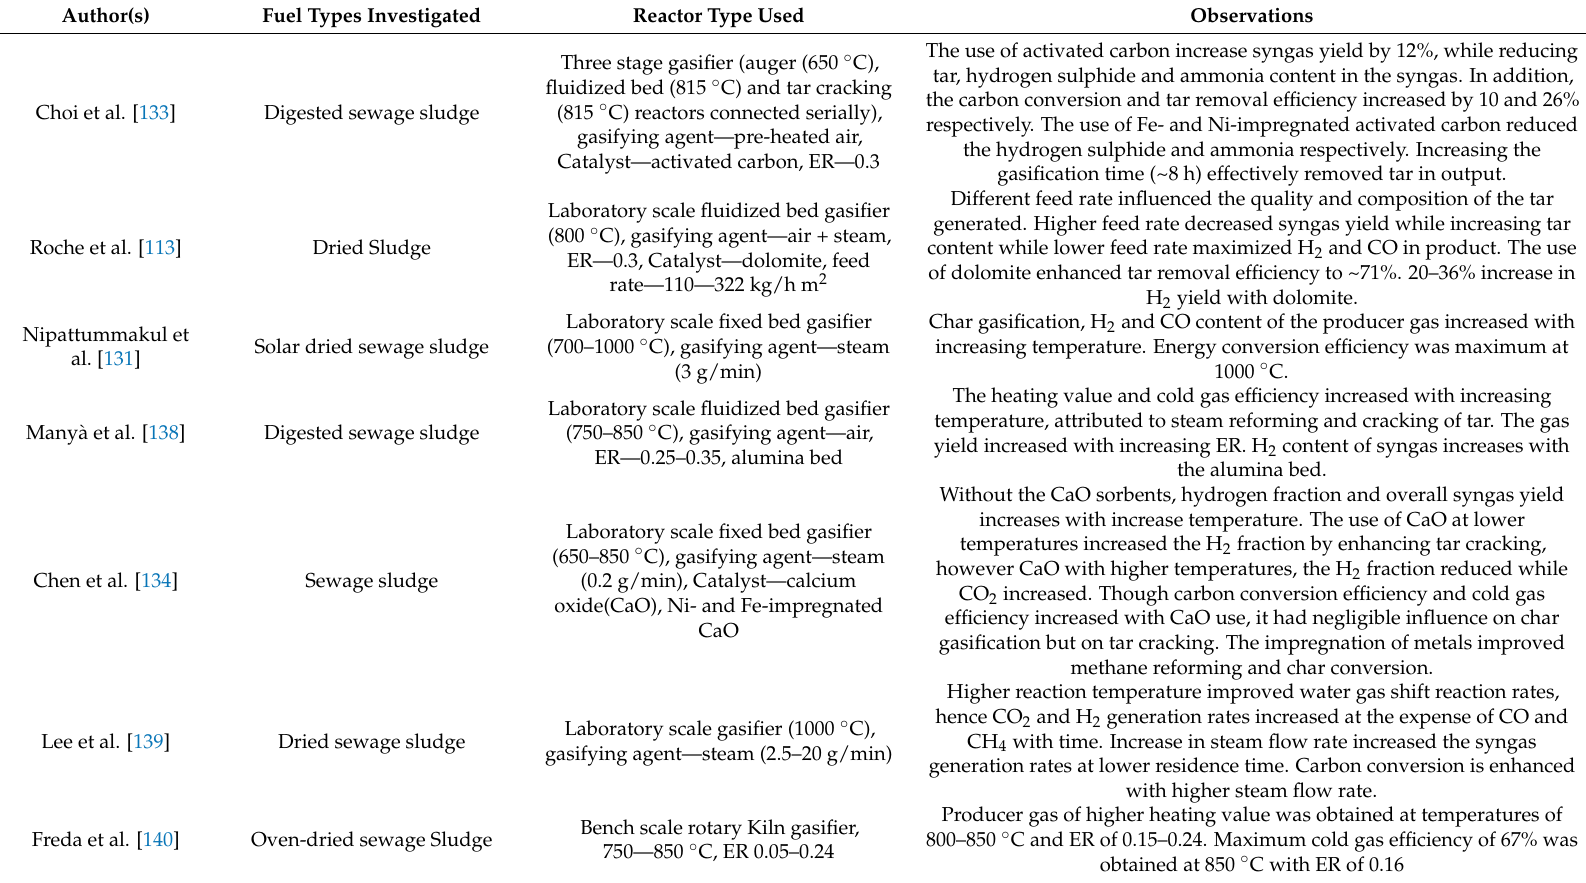
Table 5. Summary of key research on gasification of sewage